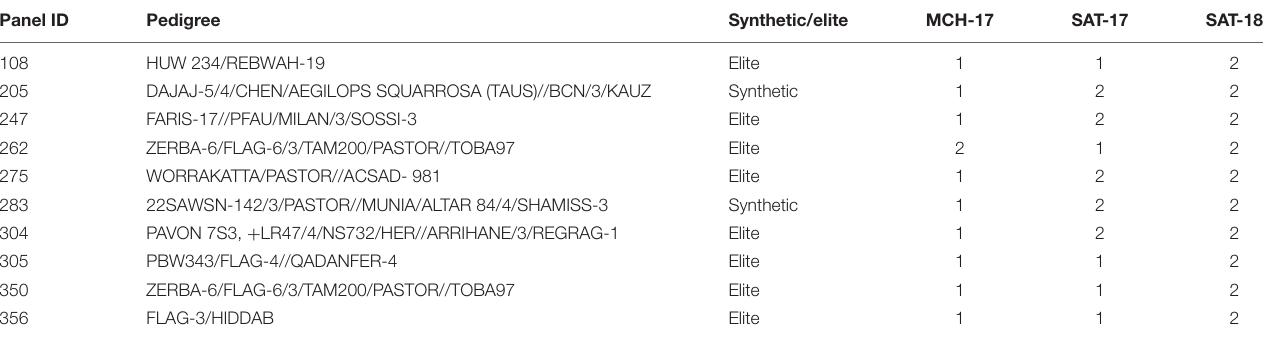
TABLE 1 | List of resistant (R) advance breeding lines from Septoria Association Mapping Panel (SAMP) against Septoria tritici blotch at Sidi Allal Tazi during 2017 (SAT-17), 2018 (SAT-18), and at Marchouch during 2017 (MCH-17) in Morocco. Panel